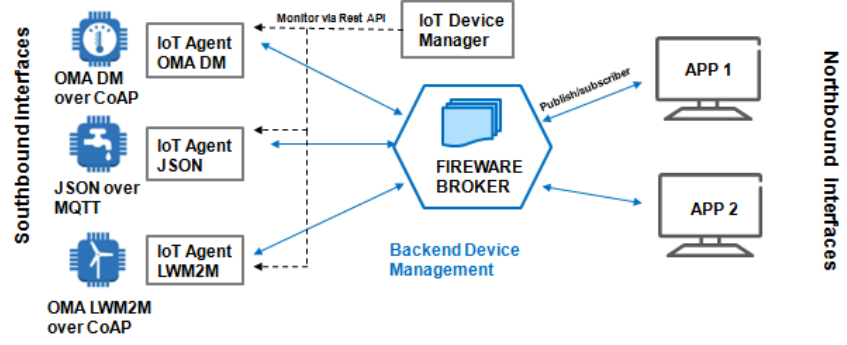
Figure 24. Illustration of the Fiware